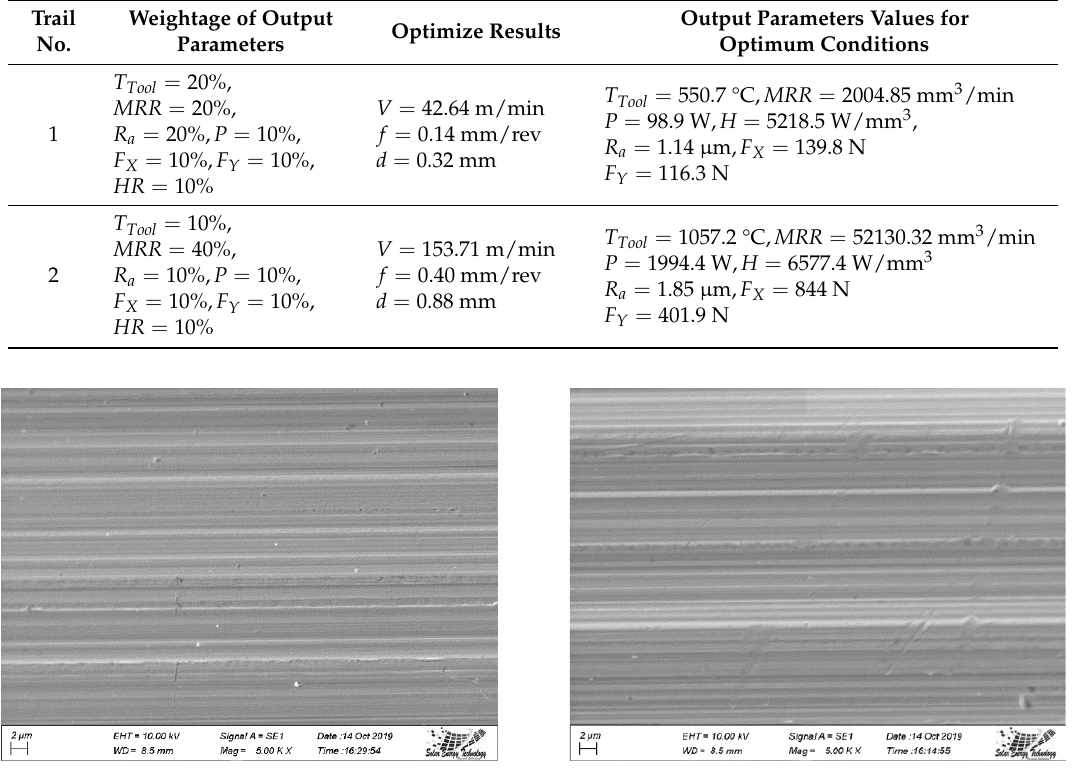
Table 8. Optimization results for di ff erent weightage of output parameters.